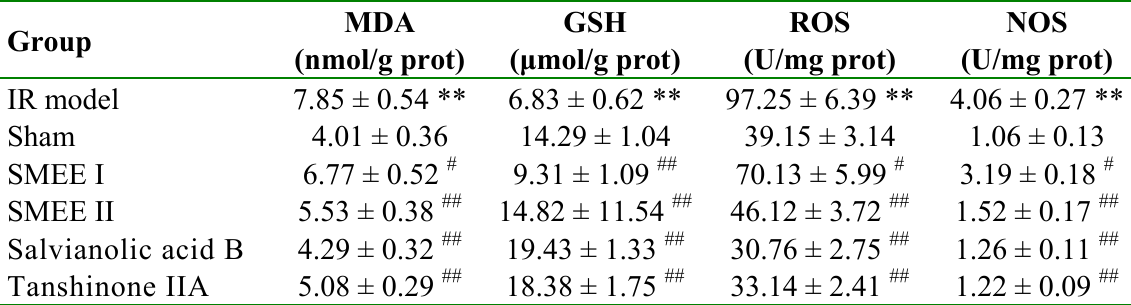
Table 5. Effect of S. miltiorrhiza ethanol extract on the myocardium MDA, GSH level, and ROS, NOS